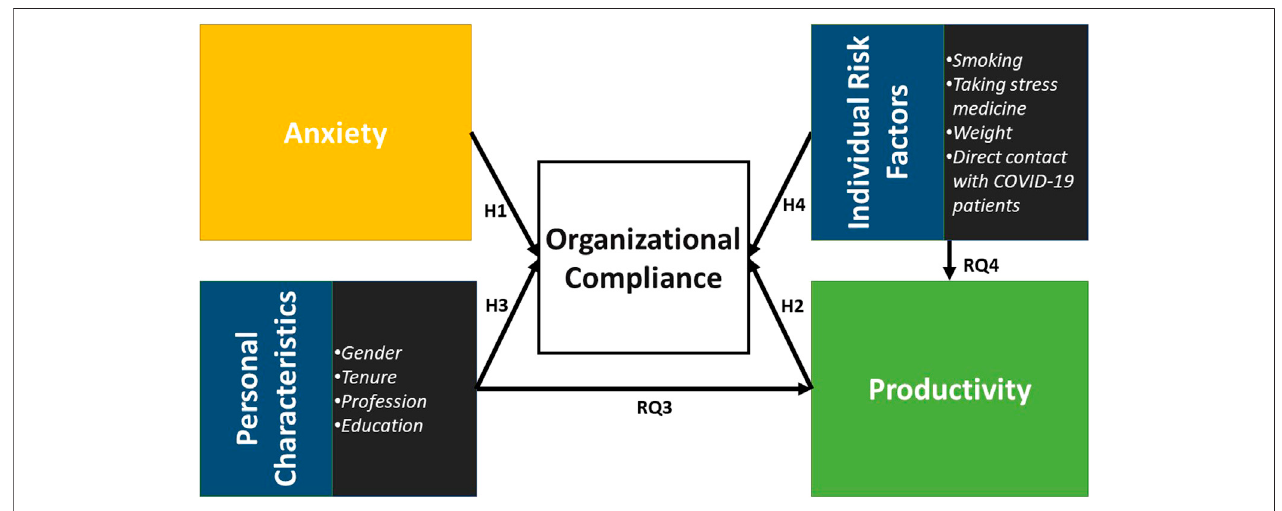
FIGURE 1 | The study